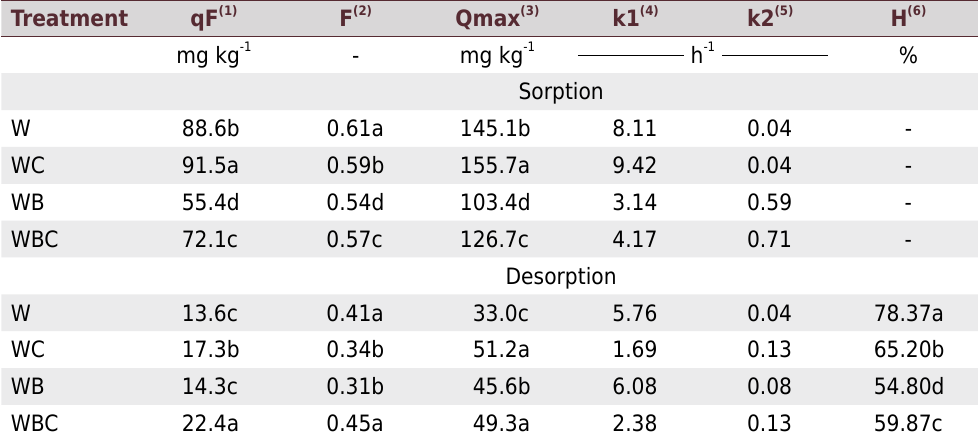
Table 3. Kinetic parameters of P sorption by the pseudo-first-order model and hysteresis indices for sorption in Fe mining waste (W) enriched with organic compost (WC), biochar (WB), and a combination of both amendments (WBC)